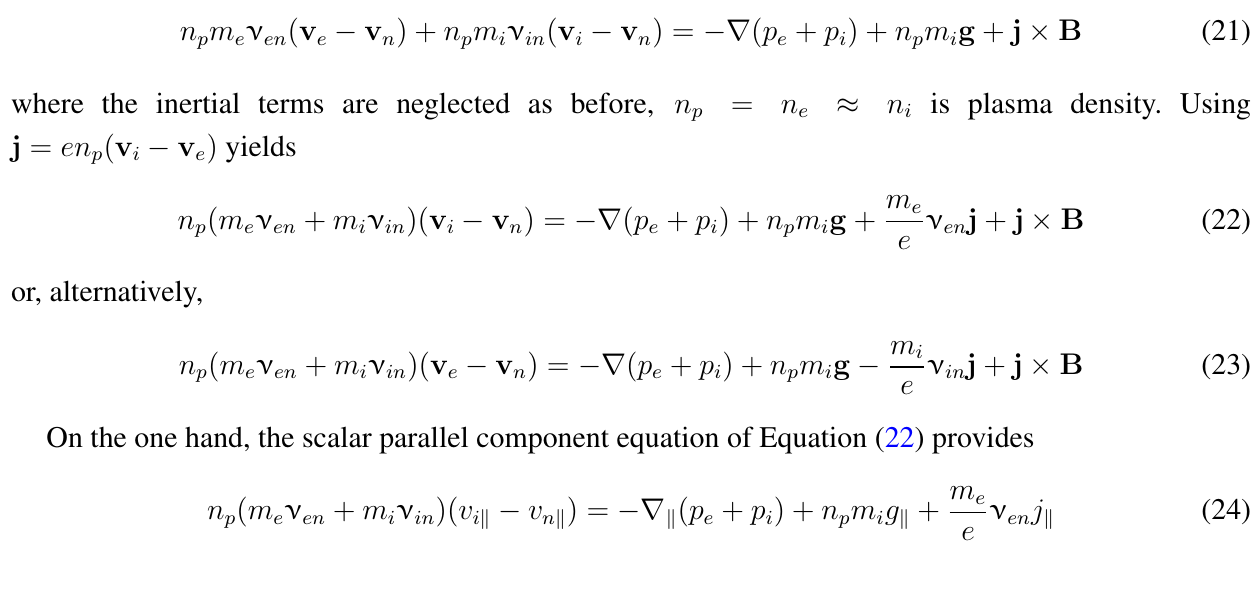
Figure 3. Vertical profiles of ion and electron densities n temperatures T and T (upper right panel) from the IRI-2012 empirical model [96] at i e two different locations; corresponding ion-neutral and electron-neutral collision frequencies ν and ν (lower left panel) from Equation (8); and, three dimension-free conventional in en conductivities σ ∗ , σ ∗ , and σ ∗ from Equation (20) (lower right panel), which are independent P H (cid:107) of geographic locations and universal